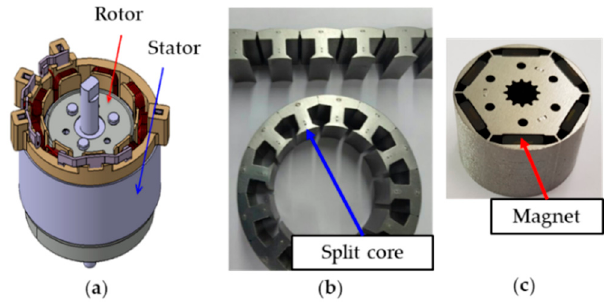
Figure 10. Prototype of optimal design: ( a ) Assembly; ( b ) Stator; ( c ) Rotor.